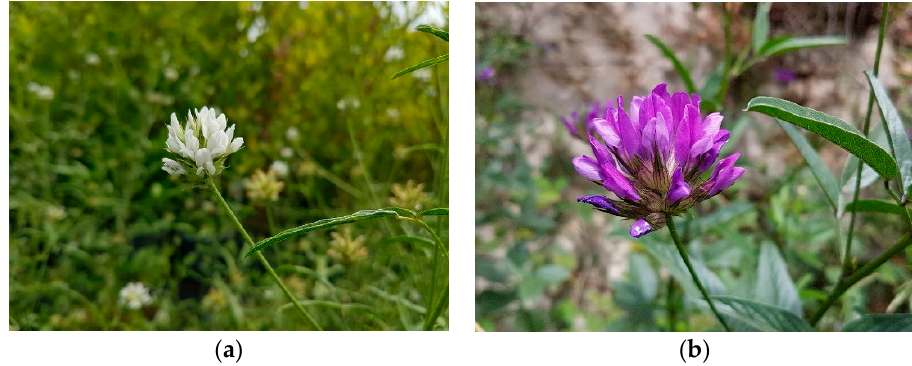
Figure 13. ( a ) Bituminaria basaltica ; ( b ) Bituminaria bituminosa .